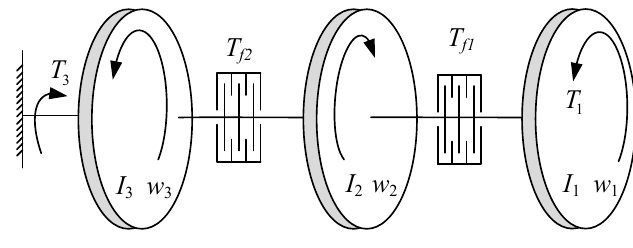
Figure 8. Transfer torque dynamics model